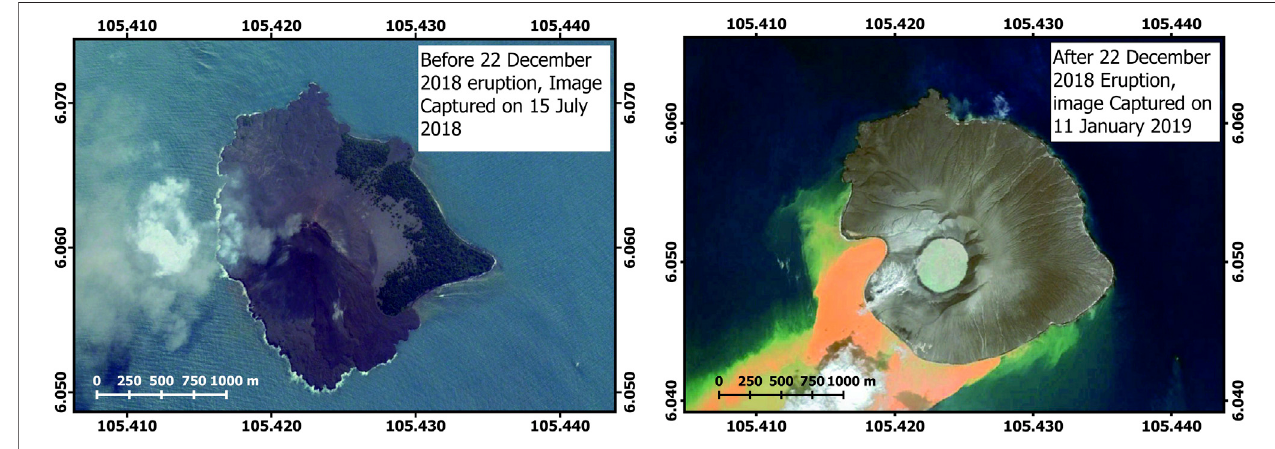
FIGURE 2 | Google satellite imagery before and after 2018